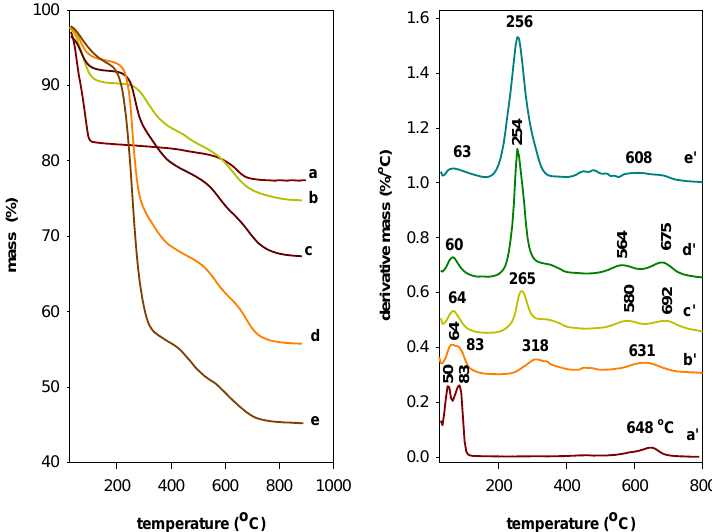
Figure 10. TGA ( left )/DTG ( right ) curves of (a, a’) PG clay modified with C16TMAbr solution at different concentrations (b, b’) 0.40 mmol, (c, c’) 0.80 mmol. (d, d’) 1.65 mmol and (e, e’) 2.40 mmol.